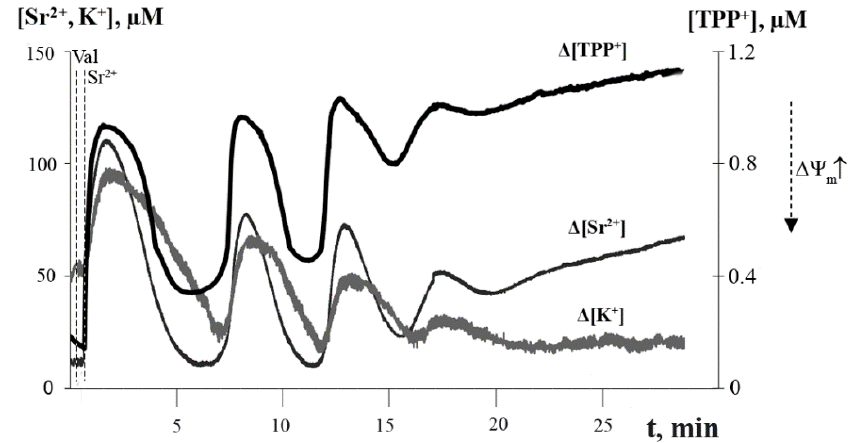
Figure 2. Simultaneous recording of Sr 2+ /valinomycin-induced oscillations in Sr 2+ and K + fluxes and membrane potential of rat liver mitochondria. The medium contained 20 mM sucrose, 1 mM KCl, 1.5 µM TPP + , 1 µM CsA, 1 µM rotenone, 5 mM succinic acid, and 12.5 mM Tris (pH 7.3). Additions: 2 ng valinomycin and 45 nmol SrCl 2 /mg of protein. The typical traces are presented ( n = 5).